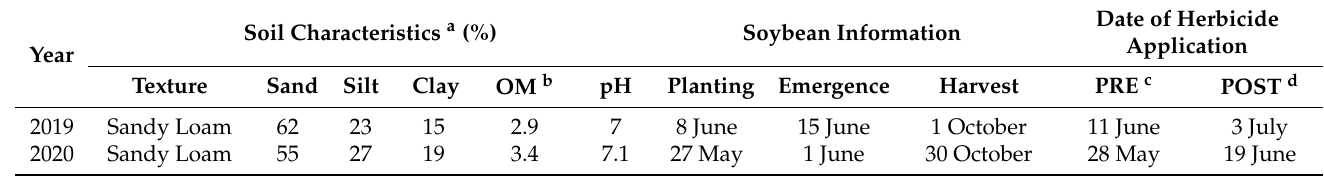
a Soil characteristics were obtained from samples taken to a 15 cm depth below the soil surface and analyzed by